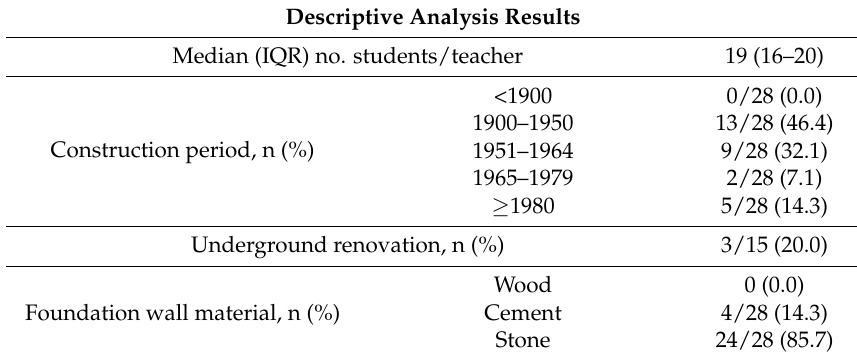
Table 1. Radon measurements in 28 schoolrooms of 19 different buildings. Descriptive